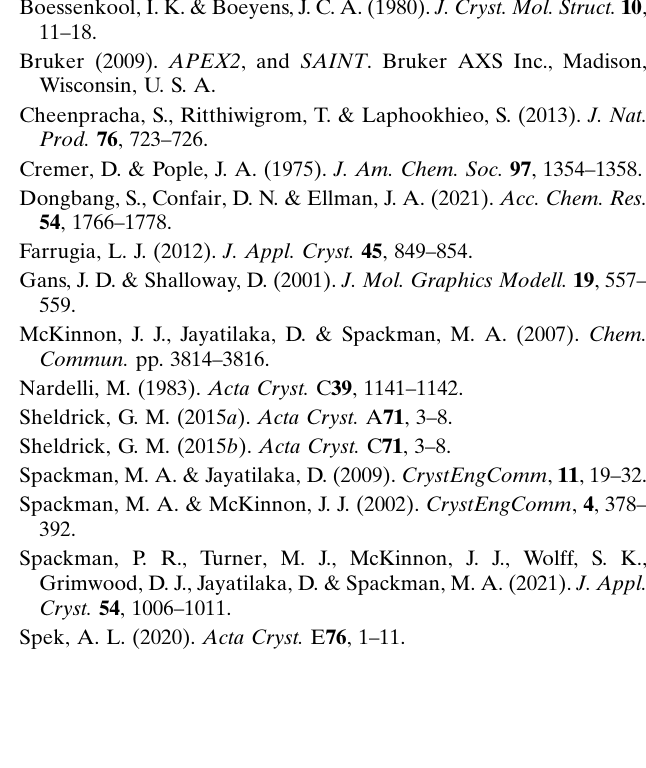
Crystal data Chemical